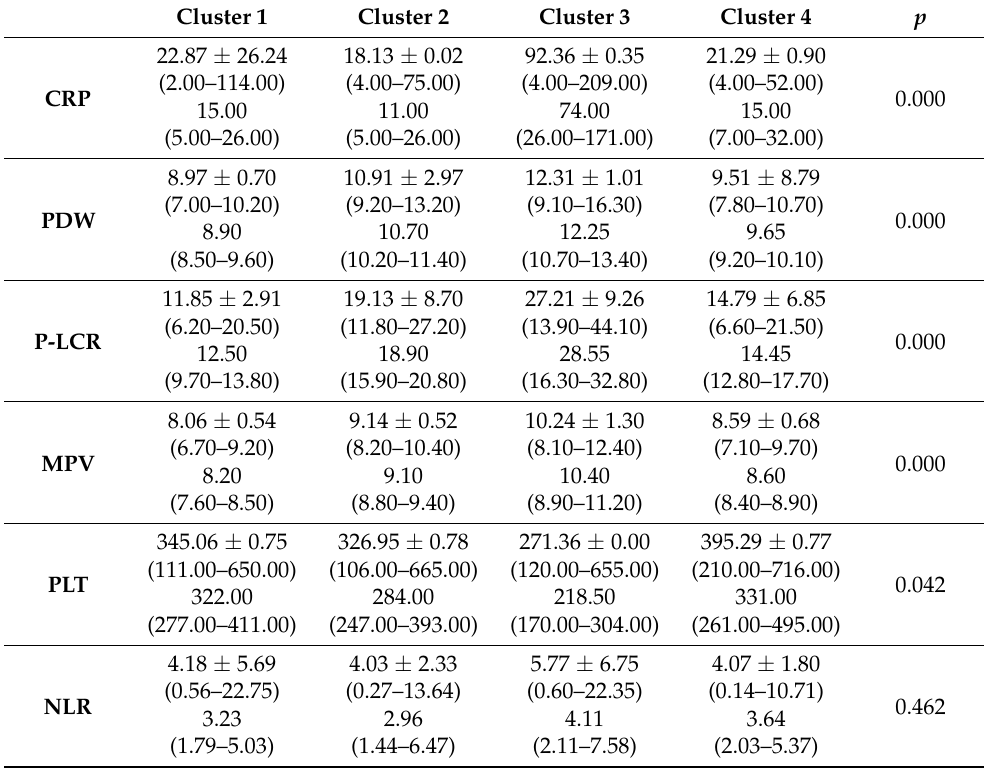
Table 1. Description of the four clusters identified by the two step cluster